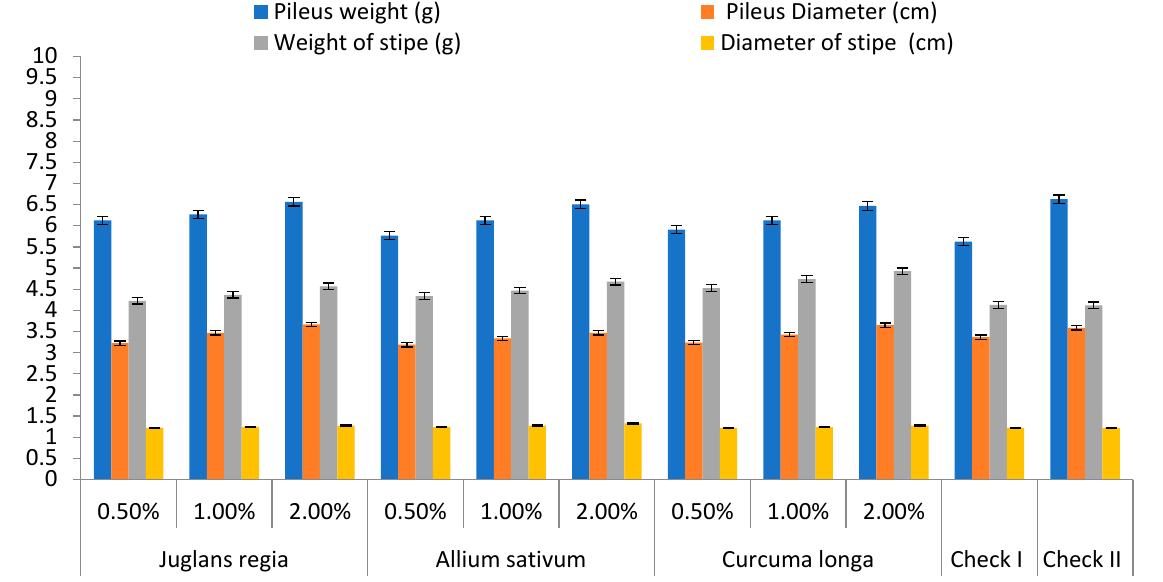
Figure 1. Efficacy of botanical extracts on quality parameters of white button mushrooms ( Agaricus bisporus ) at concentrations between 0.5 to 2%. Values are the mean and standard errors of three replications; Check I = infested-untreated; Check II =